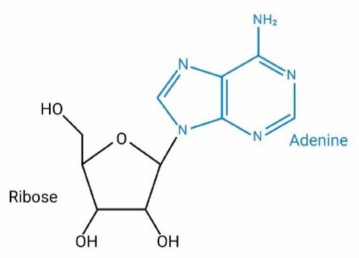
Figure 1. Structure of